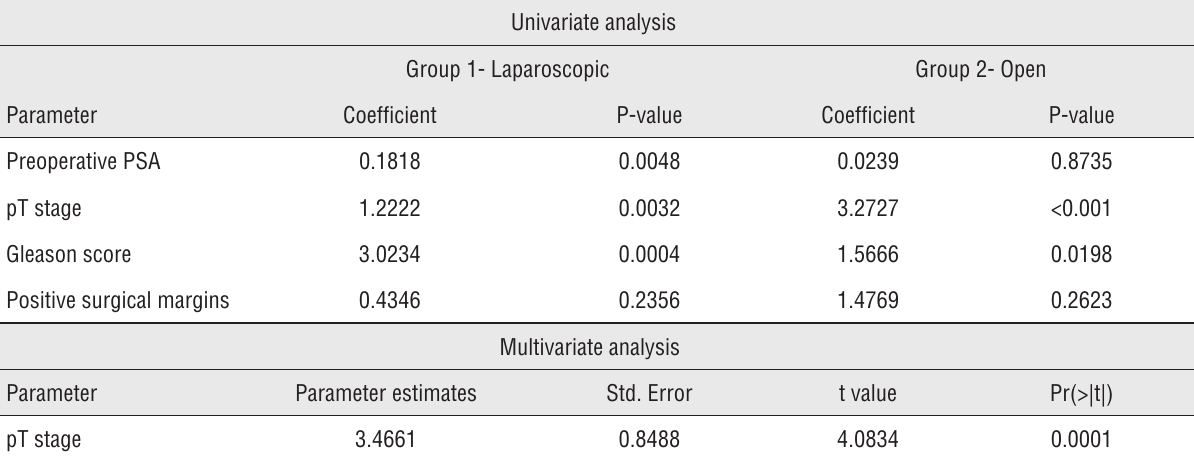
Table 6 - Linear regression model for parameters association with BC failure.